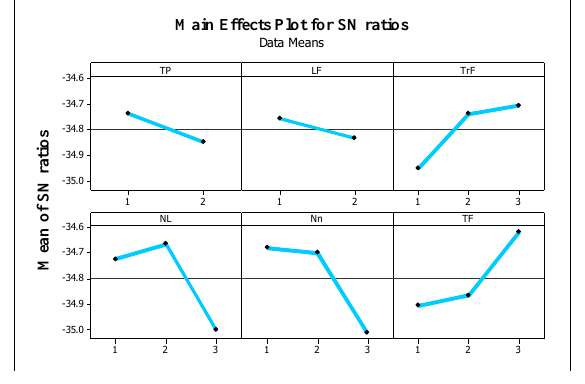
Figure 6. Force estimation by the optimized